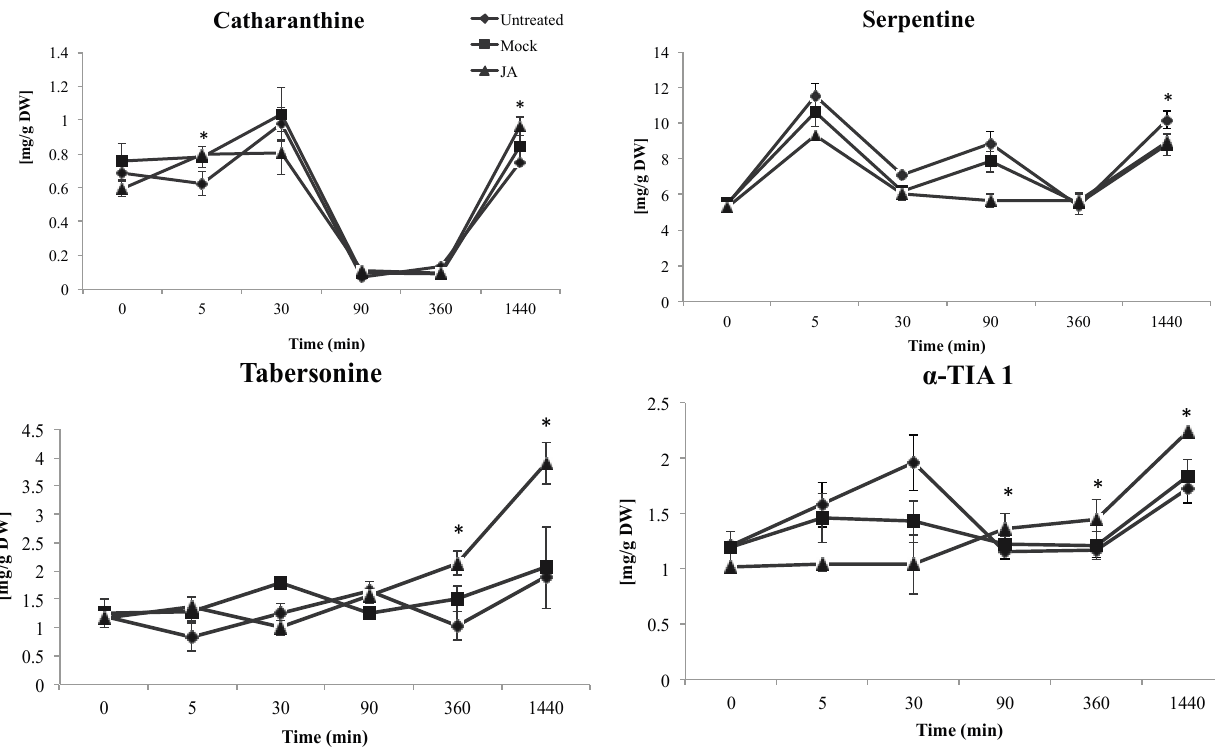
Figure 3. Profiles of the TIA with the most significant variations in cell suspension cultures of C. roseus after JA treatment. Values are the mean ± SE of one experiment with four biological triplicates. Significant results are marked with stars (* p <